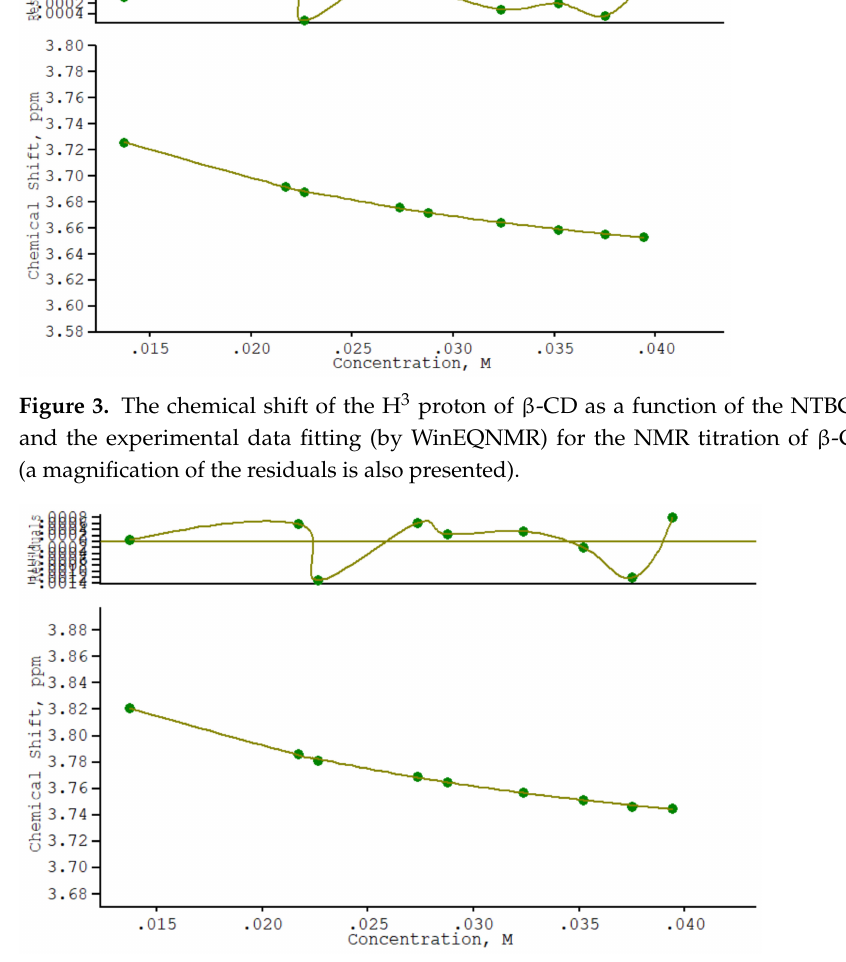
Figure 4. The chemical shift of the H 5 proton of β -CD as a function of the NTBC concentration and the experimental data fitting (by WinEQNMR) for the NMR titration of β -CD with NTBC (a magnification of the residuals is also